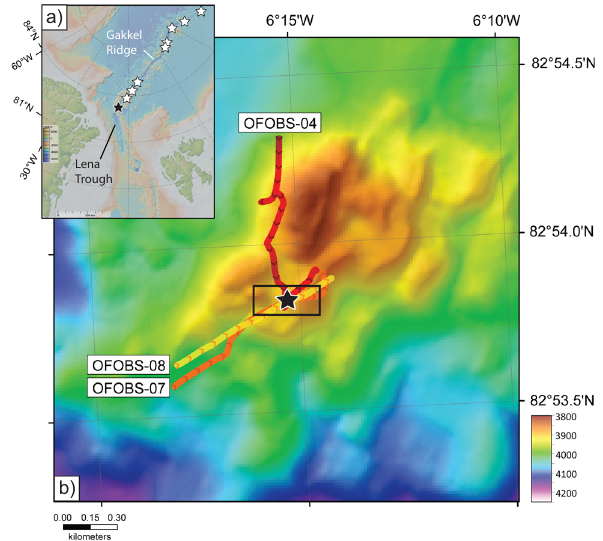
Fig. 1 | Location map for the Aurora seamount, Gakkel Ridge. a Location of the Aurorahydrothermal fi eld(blackstar),togetherwitheightadditionalhydrothermal plume sources (white stars) identi fi ed along the Gakkel Ridge during the 2001 Arctic Mid-Ocean Ridge Exploration (AMORE) expedition 7 . Figure made with Geo- MapApp (www.geomapapp.org) using data from the International Bathymetric Chart of the Arctic Ocean 69 . b Multibeam bathymetric map showing tracklines for three high resolution deep-tow surveys (OFOBS-04, − 07 and − 08) that passed directly over the Aurora vent site (black star). Colored lines denote tracklines for eachdeployment,chevronsindicatedirectionoftravel.Themultibeambathymetry displayedherewascollectedfromtheRV KronprinsHåkon in2019 16 andgriddedat 15m. Black rectangle delineates the area of sidescan sonar survey shown in Fig.